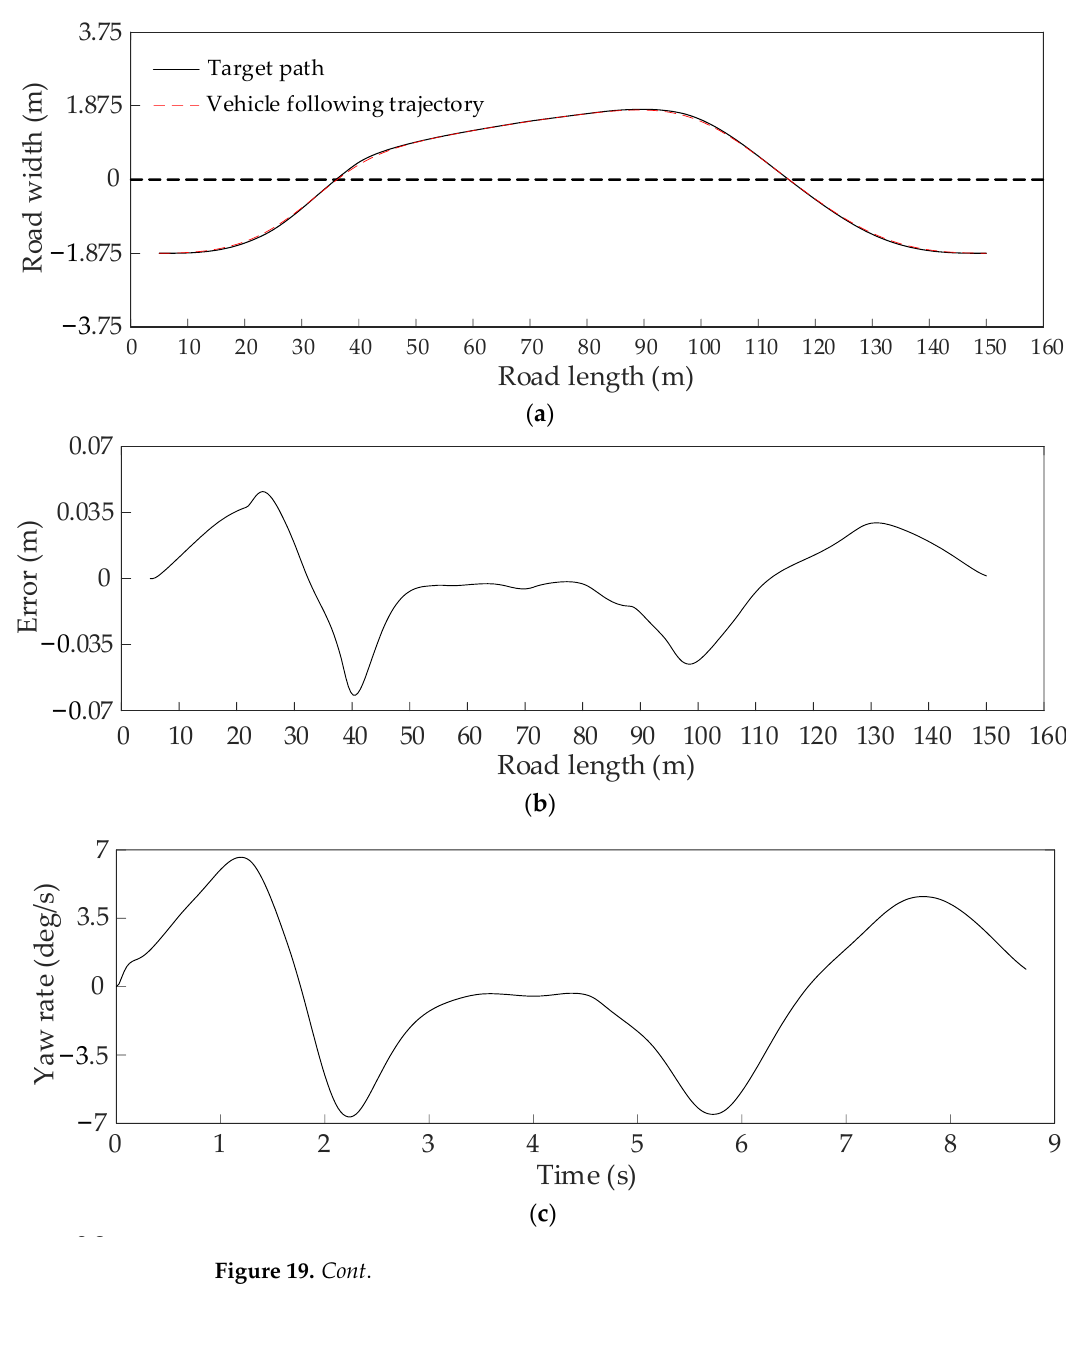
Figure 18. The path tracking results of the coherence path in a dynamic scenario with driving in opposite directions. ( a ) The path following result. ( b ) The path following error. ( c ) The yaw velocity. ( d ) The lateral acceleration.